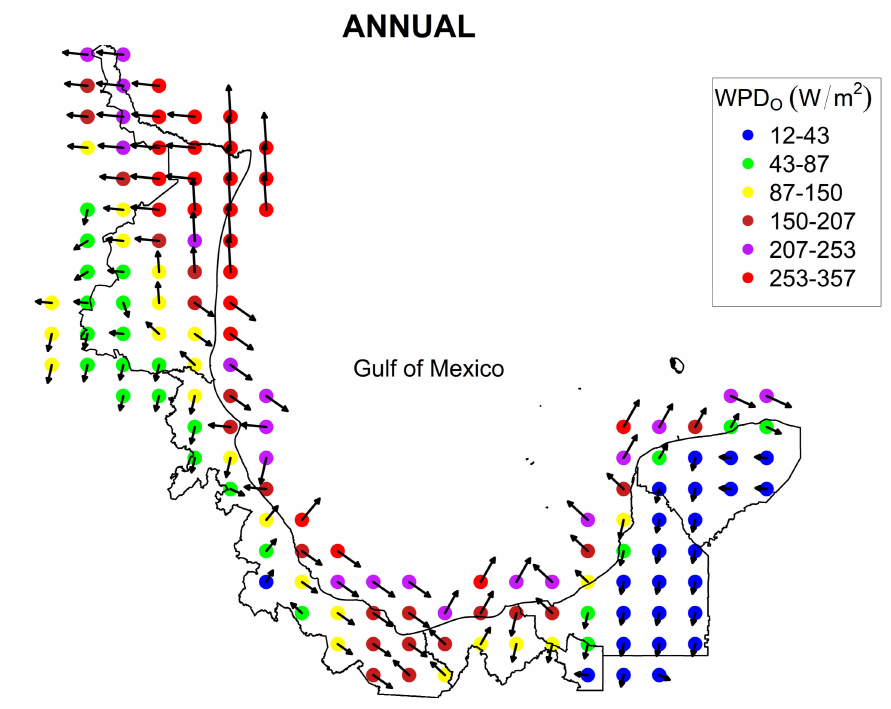
Figure 9. Annual prevailing wind direction and its WPD O along the states of the Gulf of Mexico. The highest WPD O points were along Tamaulipas and Veracruz, although Tamaulipas had more locations than Veracruz, while Veracruz has the highest resource next to the sea, Tamaulipas had it at the border with the United States of America.